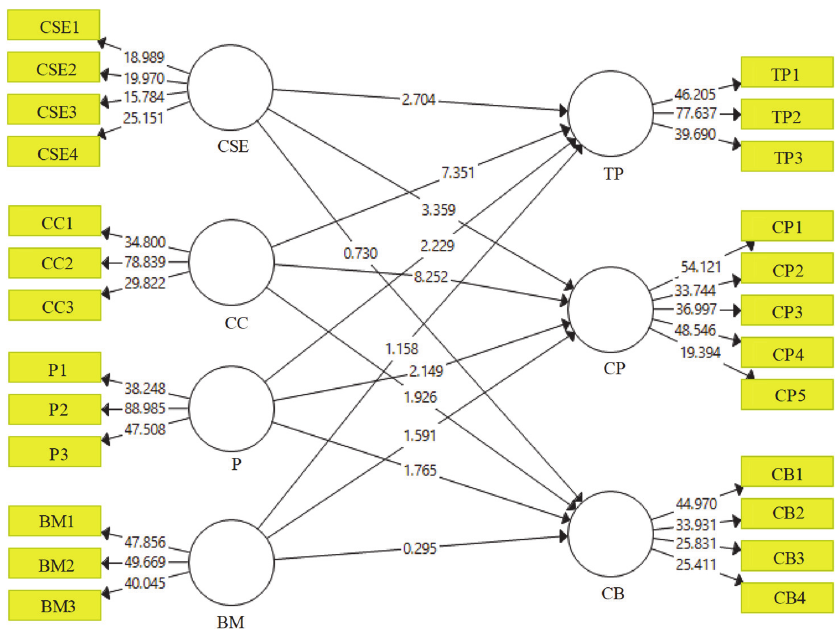
Fig. 4. Modeling digital transformation and individual job